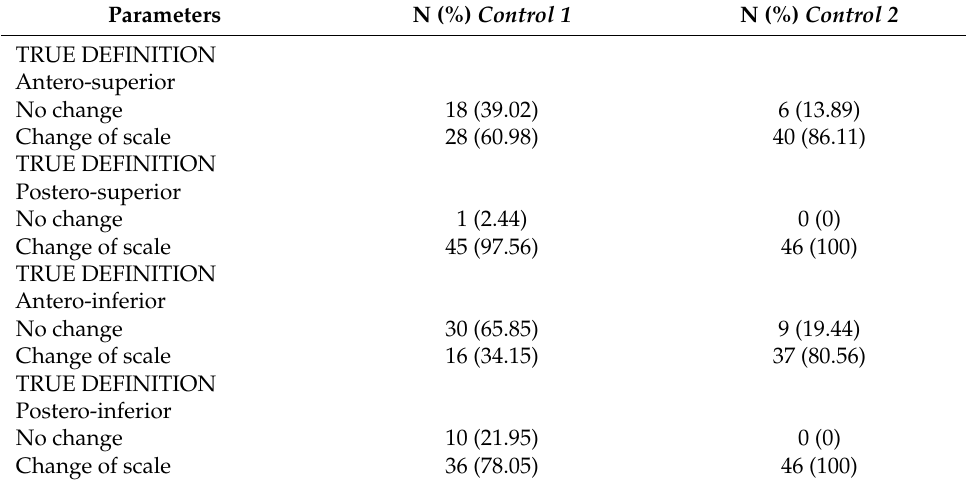
Table 4. 3M™ True Definition Scanner results.